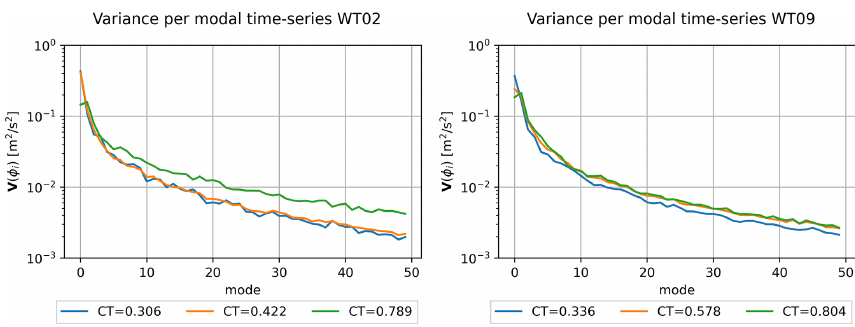
Figure 7. Variance in each modal time series for WT02 and